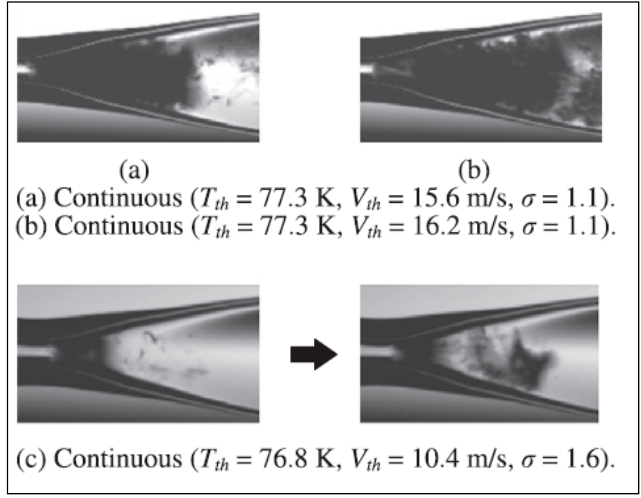
Figure 5. Photographs of cavitation at nozzle throat (D t = 1.5 mm) [60].